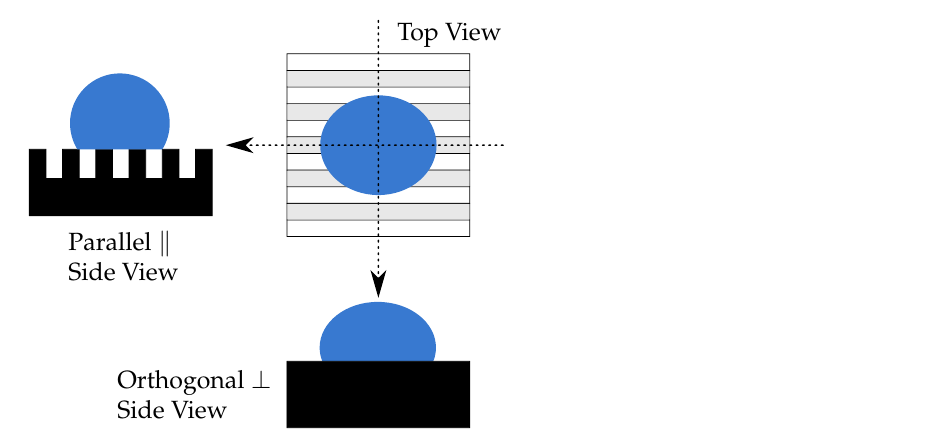
- (cid:107) -direction, ⊥